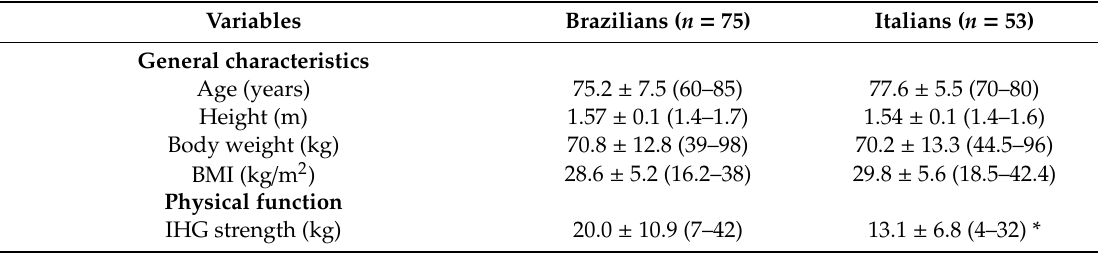
Table 1. Characteristics of study participants according to